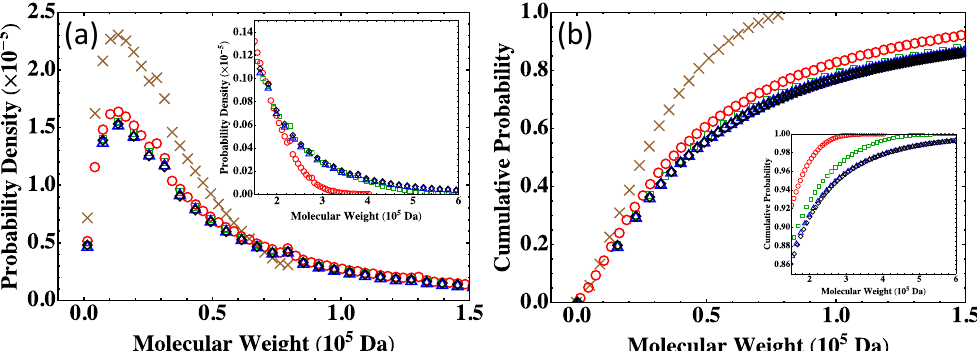
Figure 6. MWD predicted by the Flory-Stockmayer theory for systems with different sizes: ( a ) Proba- bility density and ( b ) cumulative probability. The main panels show the data in the low molecular weight region, while the insets show the data in the high molecular weight region. Data are for S 1 (brown crosses), S < (red circles), S 10 (green squares), S 50 (blue triangles), and S 80 (black diamonds).